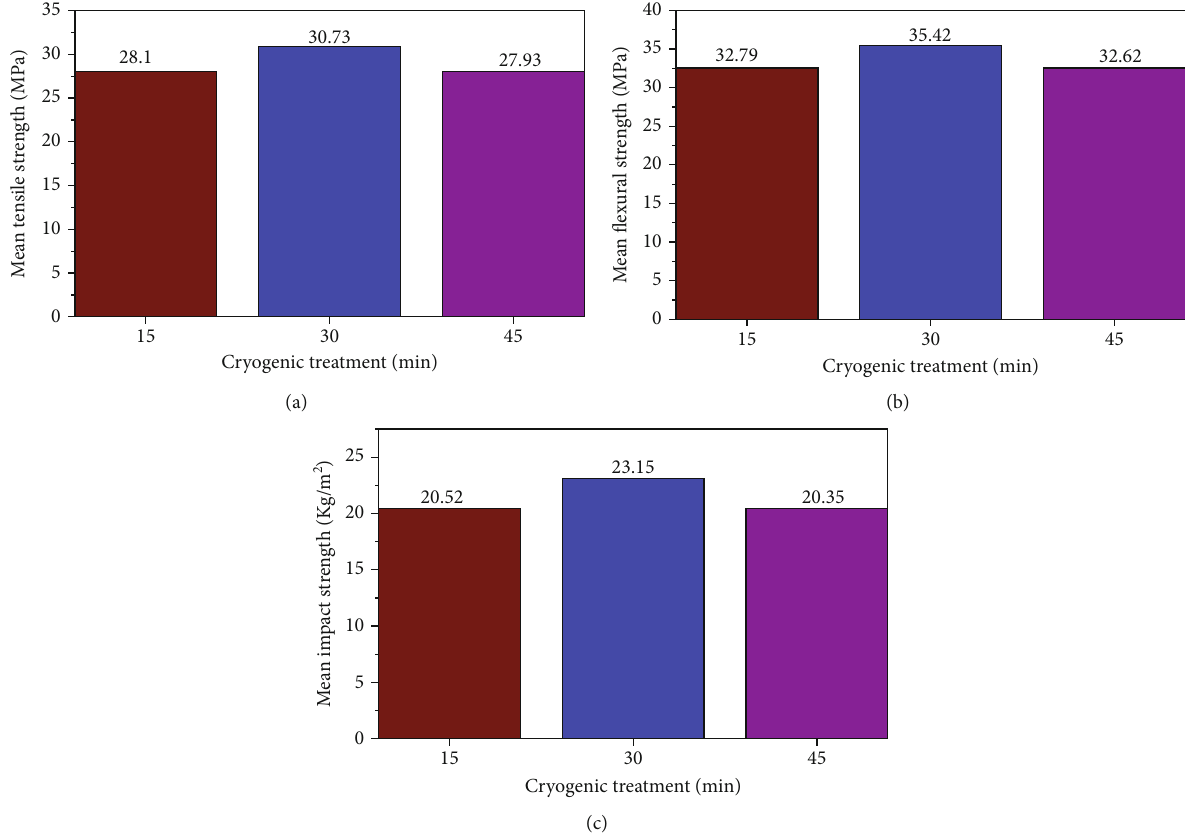
Figure 5: Result of cryogenic treatment on the mechanical characteristics.